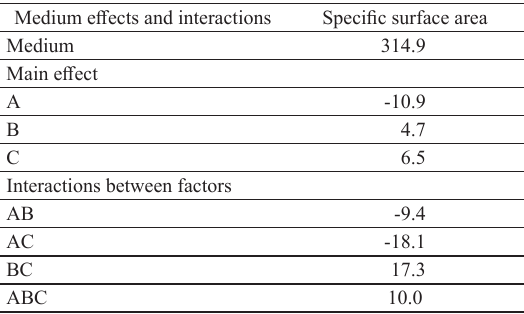
Table 6. Full factorial experimental design results for specific surface area.